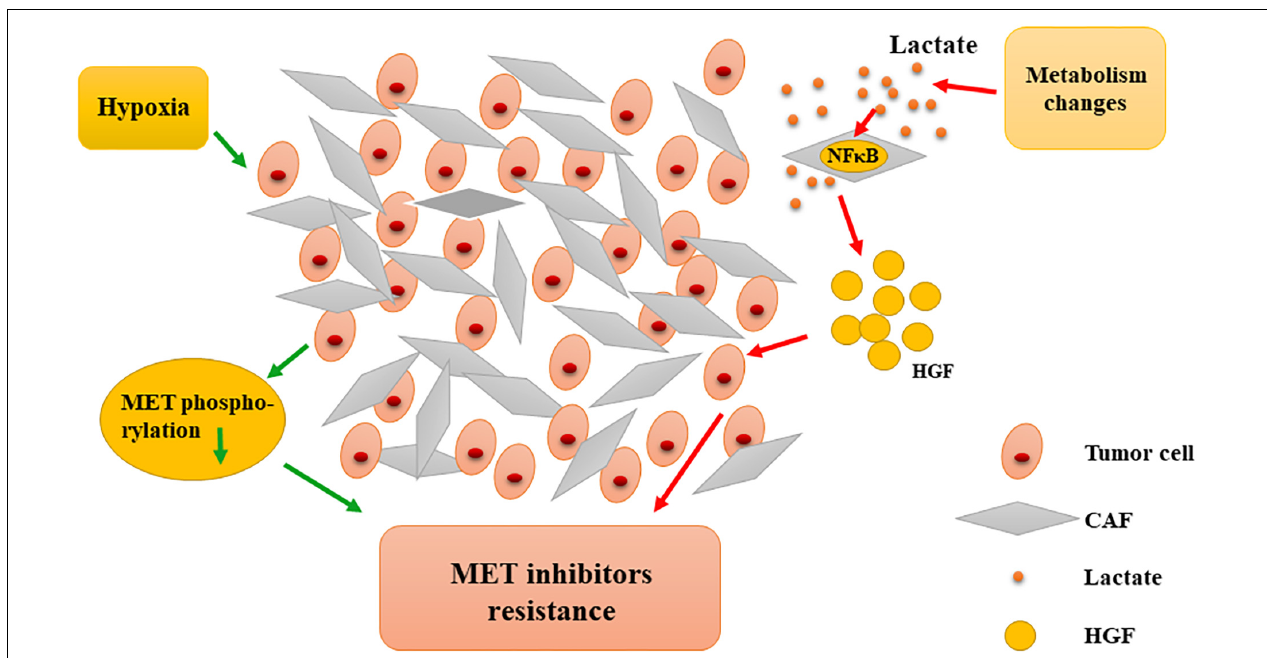
FIGURE 5 | Microenvironmental interference in resistance to MET-targeted therapy. Hypoxia induces the reduction of MET phosphorylation, causing resistance to MET inhibitors. Metabolic changes contribute to tumor cells’ resistance to MET inhibitors by promoting CAFs to secrete more HGF. CAF, cancer-associated fibroblast; HGF, hepatocyte growth factor; NF κ B, nuclear factor- κ